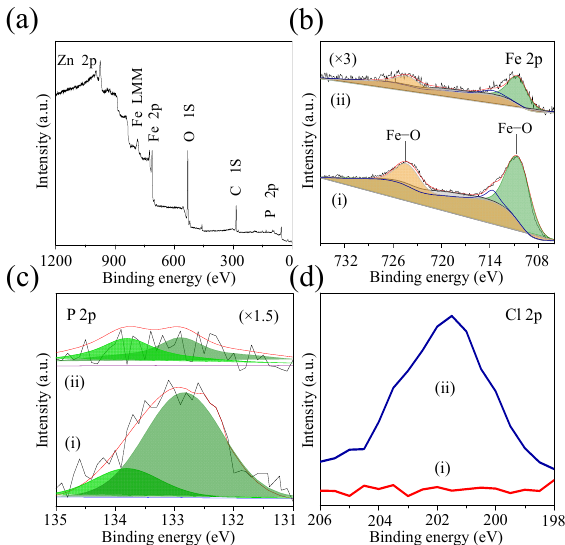
Figure 7. ( a ) XPS survey spectrum of Fe 2 P. ( b – d ) XPS core-level spectra of Fe 2p, P 2p and Cl 2p recorded (i) before and (ii) after the test.